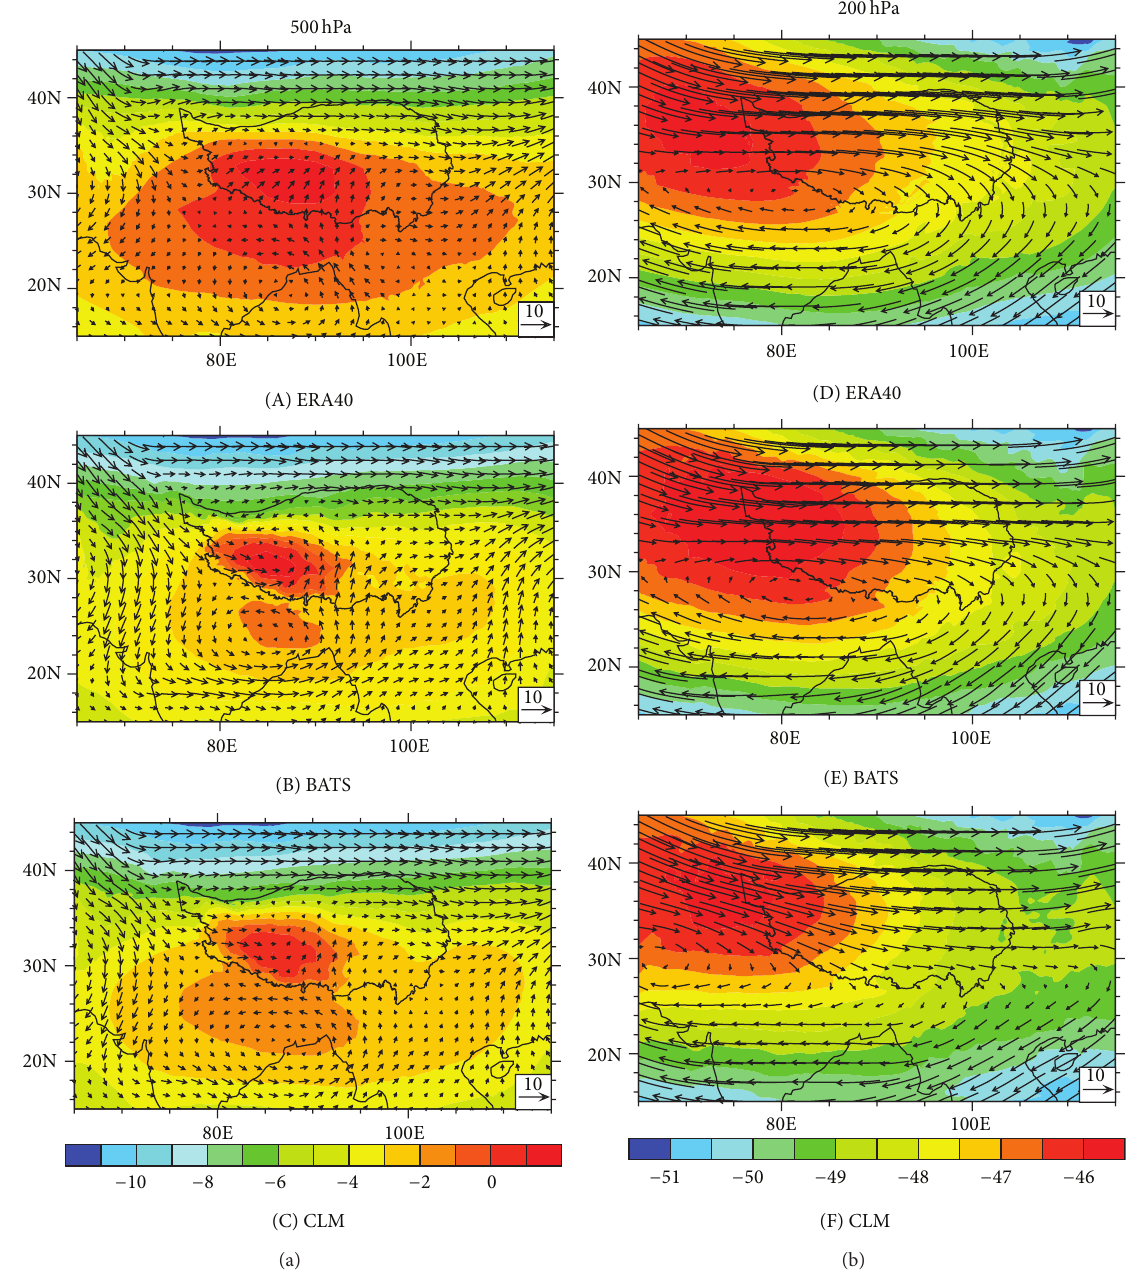
Figure 5: The summer mean wind (units: m/s) and temperature (units: ∘ C) distributions at 500 hPa (a) and 200 hPa (b) over the TP during 1992–2001. (A) and (D) represent ERA40; (B) and (E) represent BATS; and (C) and (F) represent